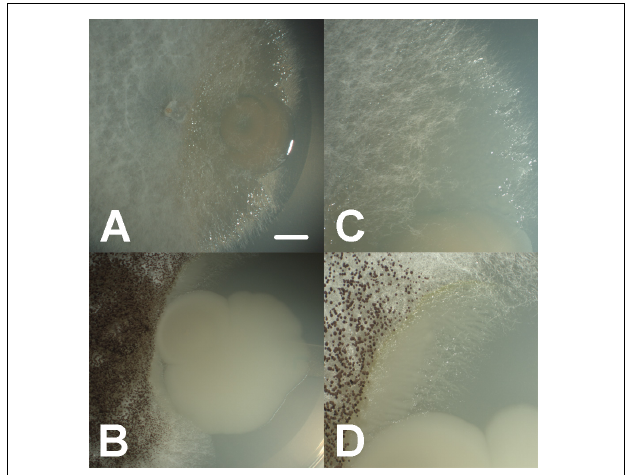
FIGURE 1 | Close synergistic fungal–bacterial physical interaction in co-culture under oligotrophic conditions during interaction bioassays, where bacteria ( Aeromonas sp. 1) are growing and accumulating toward the interface with the fungal hyphae ( Coprinellus micaceus 1 in A,C , Aspergillus niger in B,D ), forming digitiform projections shadowing hyphal growth; bars = 7 mm in A,B , 3.5 mm in C,D .